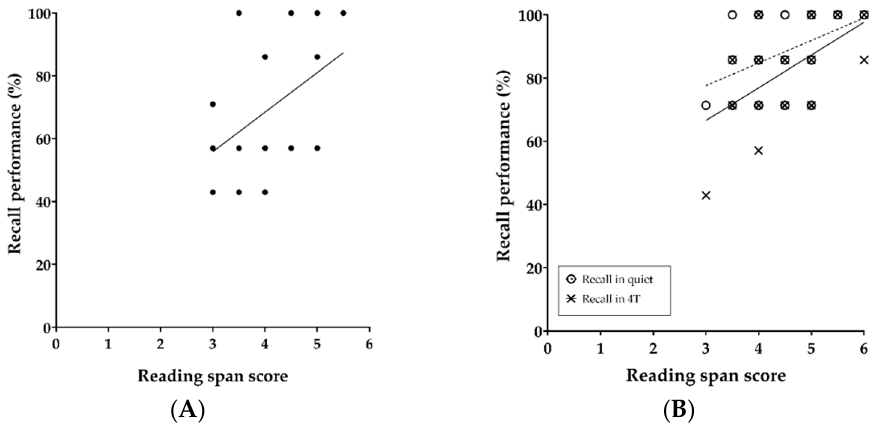
Figure 4. Scatterplots of recall performance versus reading span (RS) scores. ( A ) in stationary noise ( N = 25); ( B ) in the quiet condition (dashed line) and four-talker babble noise (solid line) ( N = 34).